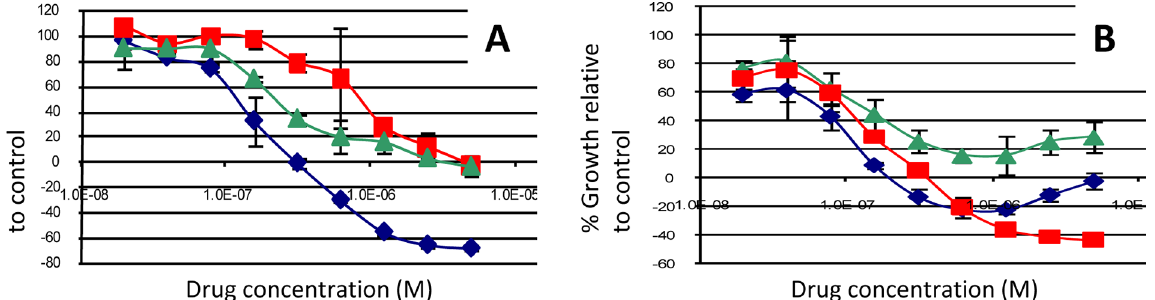
Fig 1. Examples of A. synergistic (in SUM190PT) and B. antagonistic (in AU565) interactions between lapatinib (red curve) and GSK690693 (green curve) in breast cell lines. Combination treatment is shown in the blue curve.